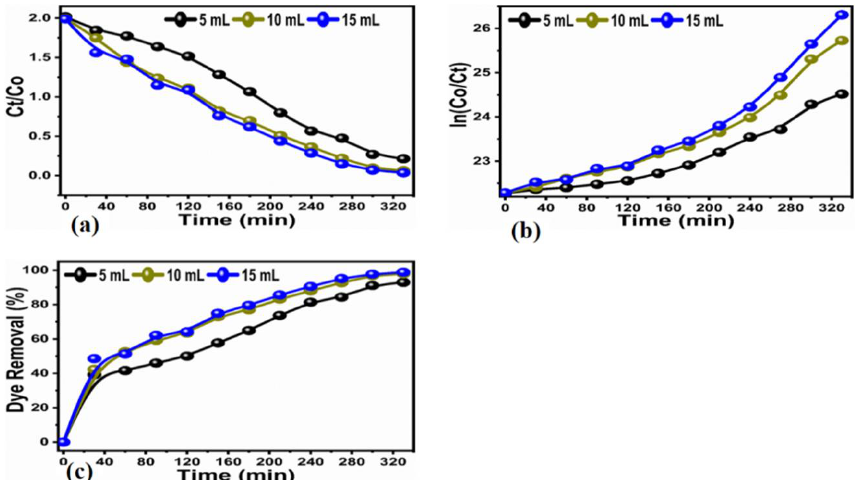
Figure 7. Plot of Ct. Co verses irradiation of photodegradation of MB at various times ( a ), pseudo-first order plot for photodegradation of MB ( b ) and the calibration curve of dye removal (%) under-natural light illumination of bulk TiO 2 material that has been hydrothermally treated with 5, 10, and 15 mL of FC leaf extracts at 30–330 min ( c ).